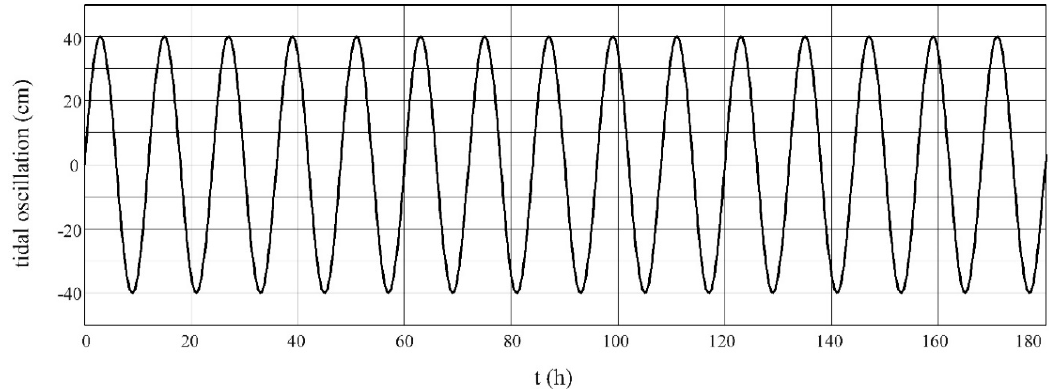
Figure 8. Outflow medium tidal level oscillation.